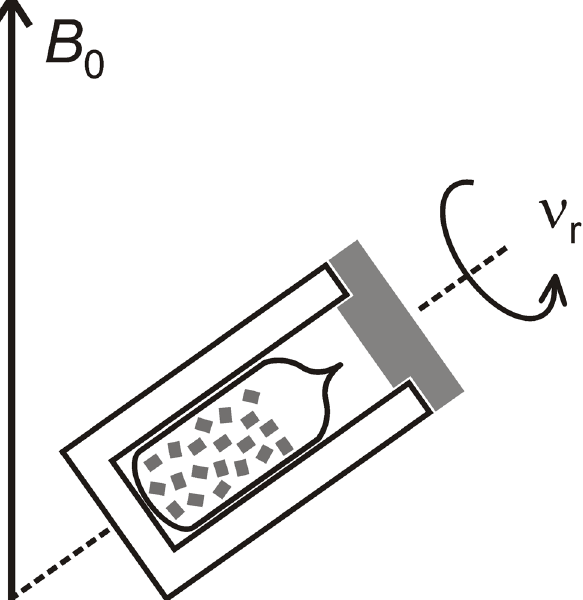
Figure 15. Schematic: MAS NMR of a sample sealed into a glass